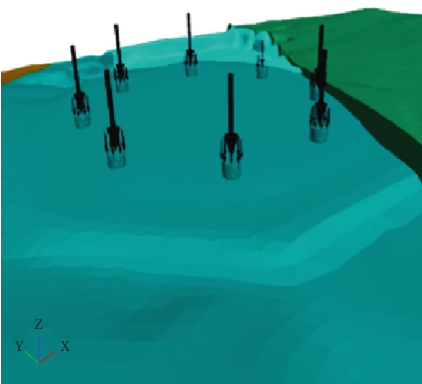
Figure 10: Load application of Banzai